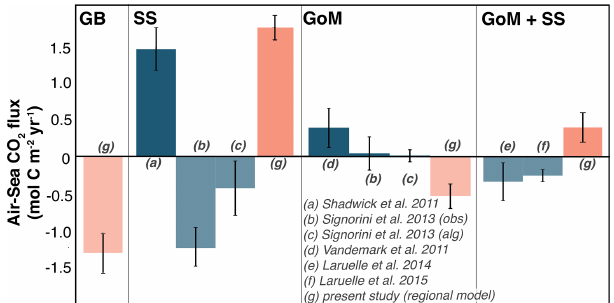
Figure 9. Annually integrated air–sea CO 2 flux for the Grand Banks (GB), Scotian Shelf (SS), and Gulf of Maine (GoM) in the model (pink) compared to literature values (blue). Positive values are net outgassing, indicated by solid bars, and negative values are net in- gassing, indicated by faded